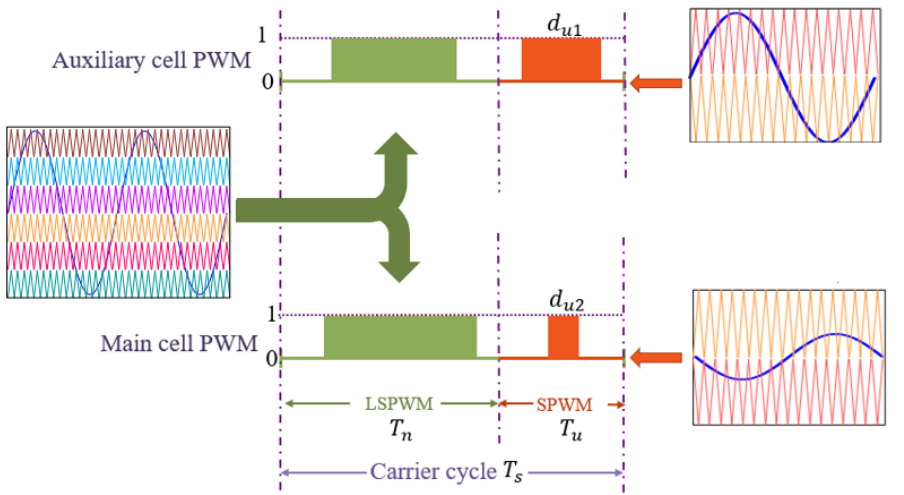
Figure 5. Proposed modulation